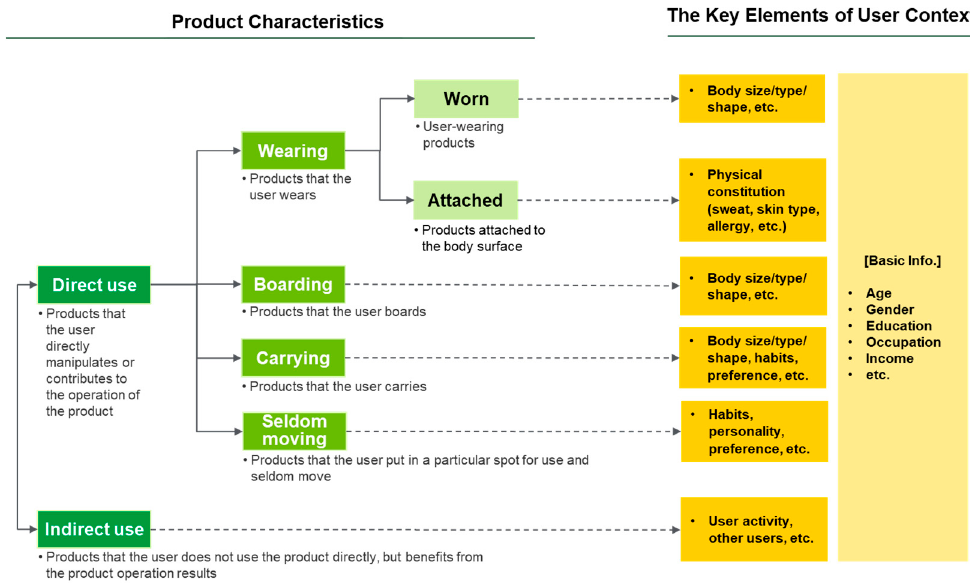
Figure 1. The Framework for the Context Analysis of a Product (User Context).